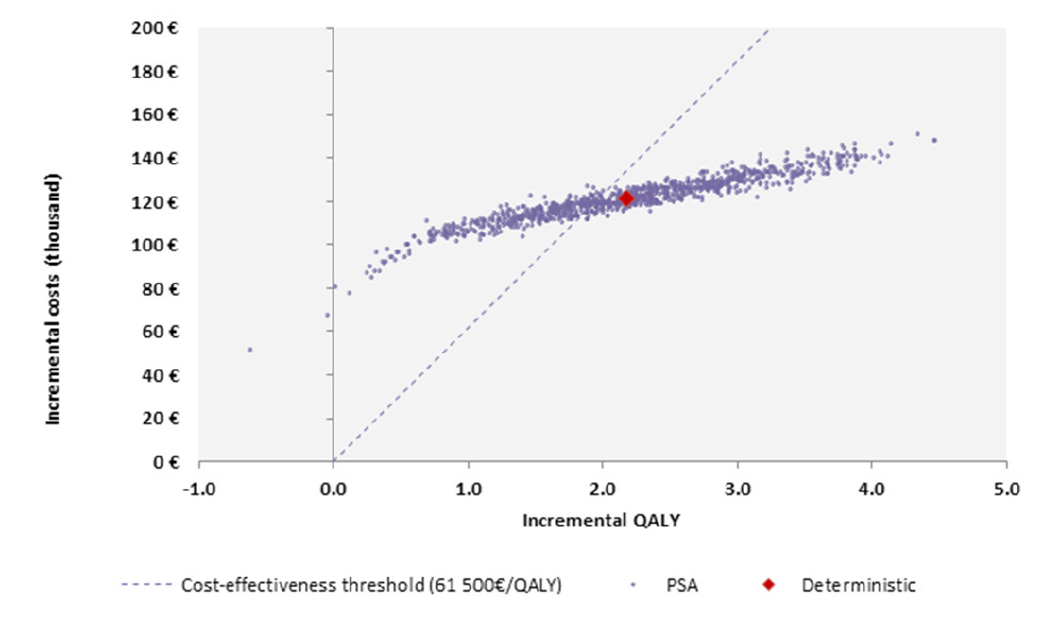
PSA: probabilistic sensitivity analysis; QALY: quality adjusted life